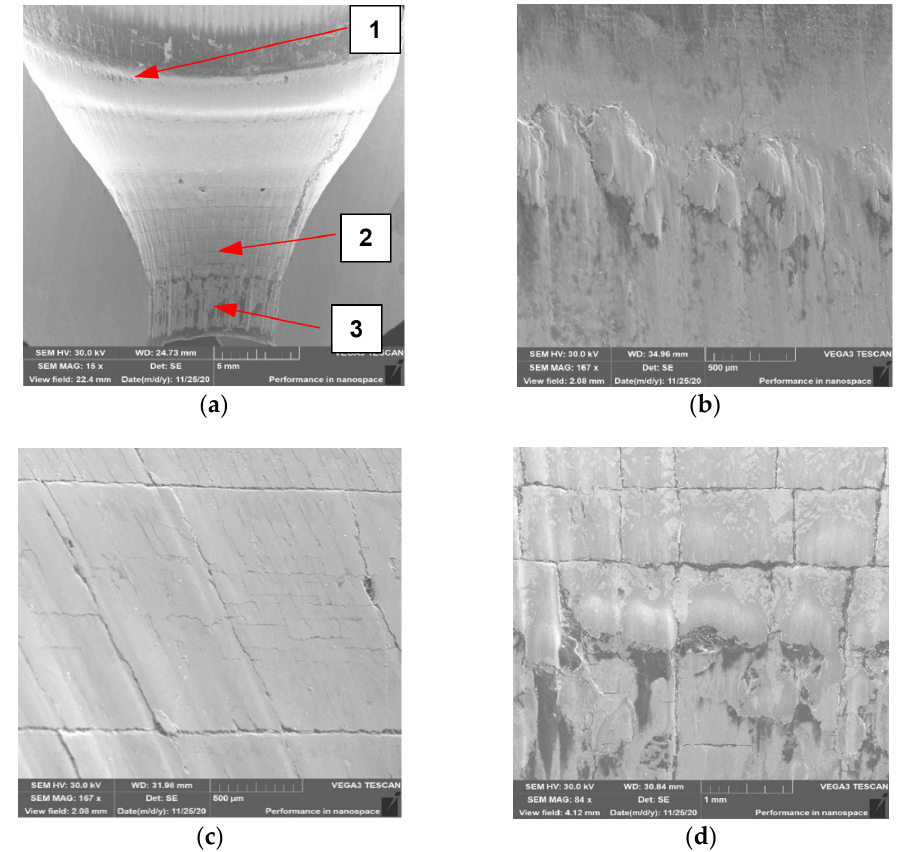
Figure 13. SEM analysis for tool 1: ( a ) photo of die cavity with marked characteristic zones formed forging in the 1st operation (in which appear different type of wear); ( b ) area in zone 1; ( c ) area in zone 2; ( d ) area in zone 3.